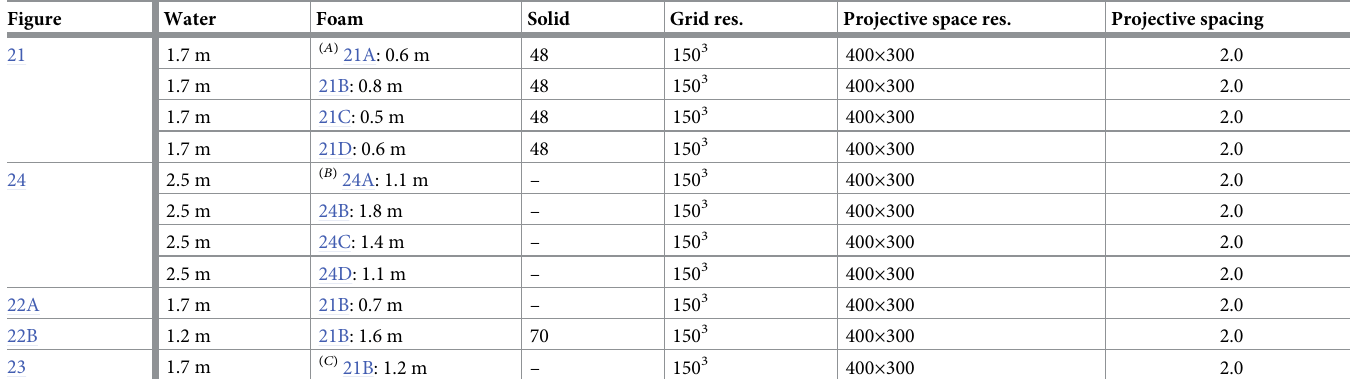
Table 3. Size of our example scene (Water: Water particles, Foam: Foam particles, Solid: Triangles of the solid, Grid res.: Grid resolution). Figure Water Foam Solid Grid res. Projective space res. Projective spacing